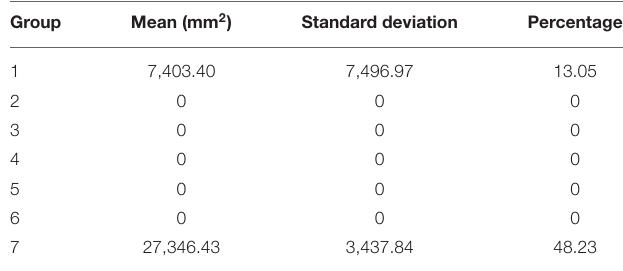
TABLE 2 | Pigmented area mean, standard deviation, and